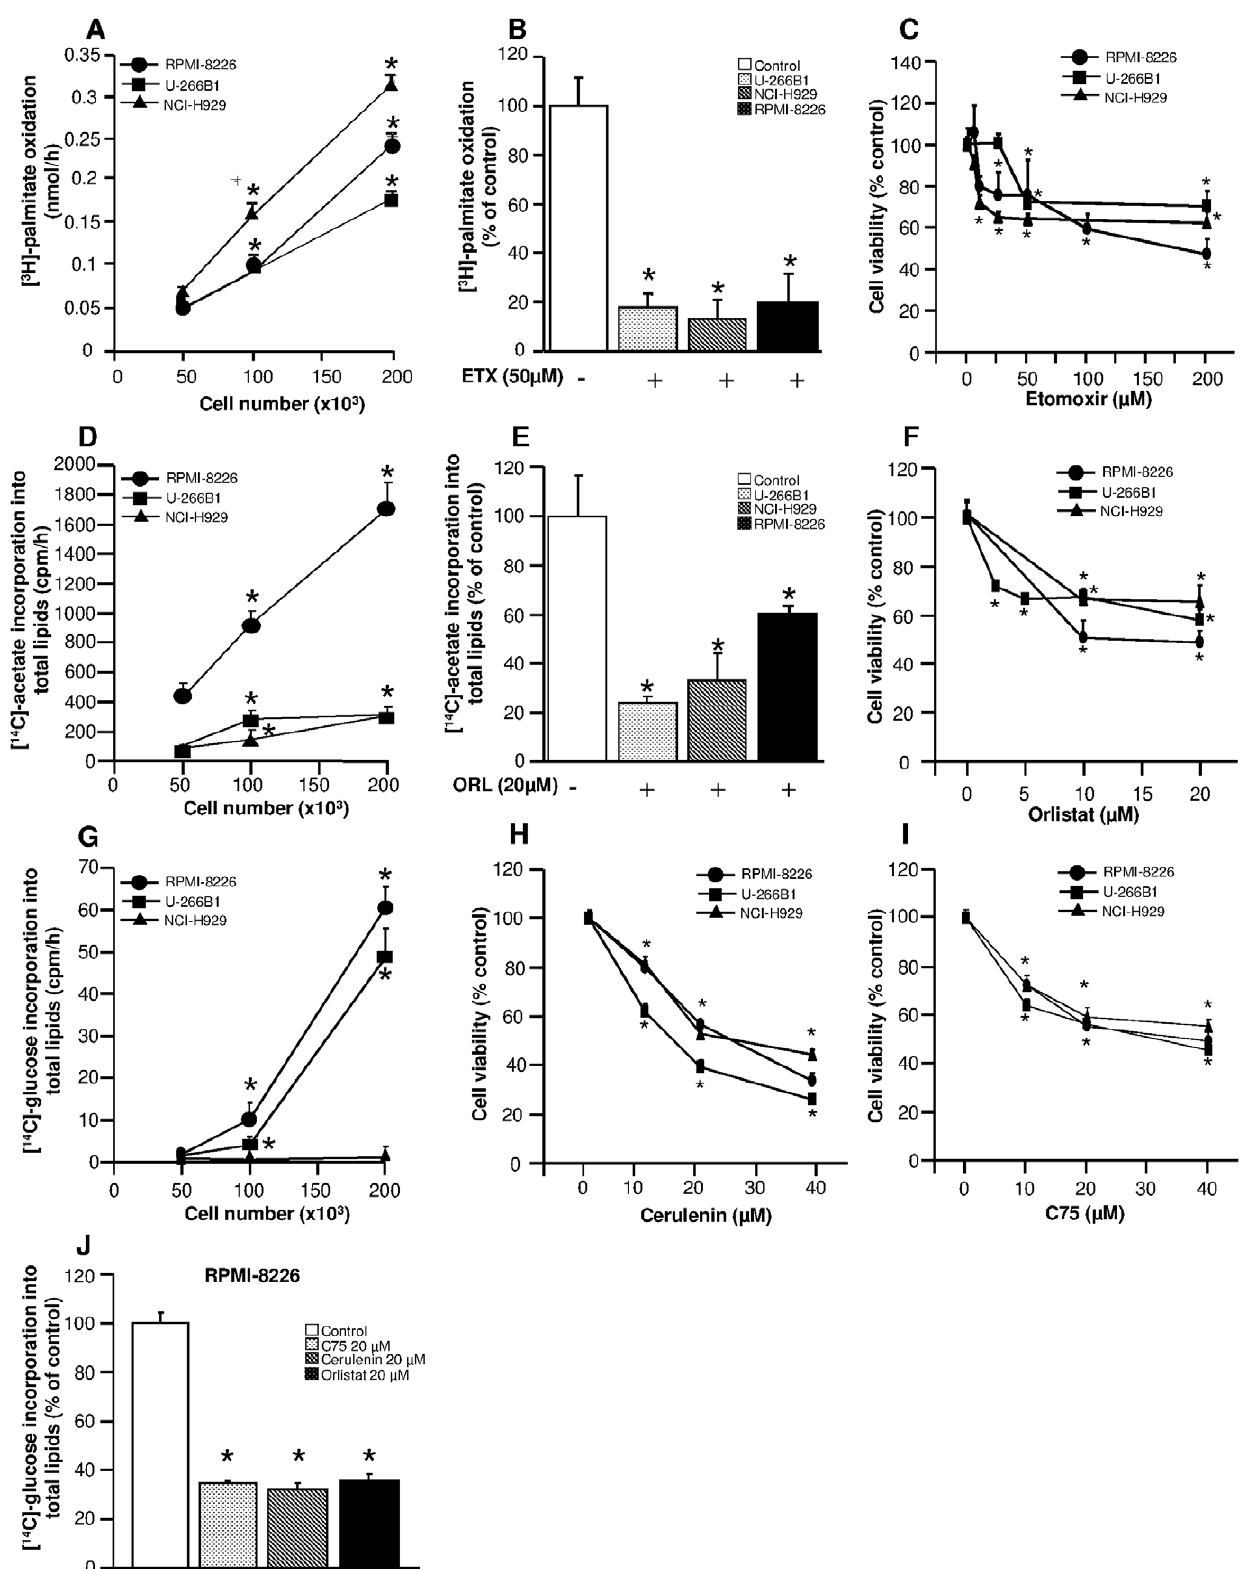
Figure 1. Effects of etomoxir and orlistat on fatty acid metabolism and cell viability in myeloma cell lines. ( A ) Mitochondrial b -oxidation of exogenous fatty acids in myeloma cell lines. RPMI-8226, NCI-H929 and U-266B1 cells were preincubated with tritiated palmitate for 18 h for measurement of fatty acid oxidation rates. Data are represented as means 6 SEM for four to six independent experiments for each cell line. *p , 0.05